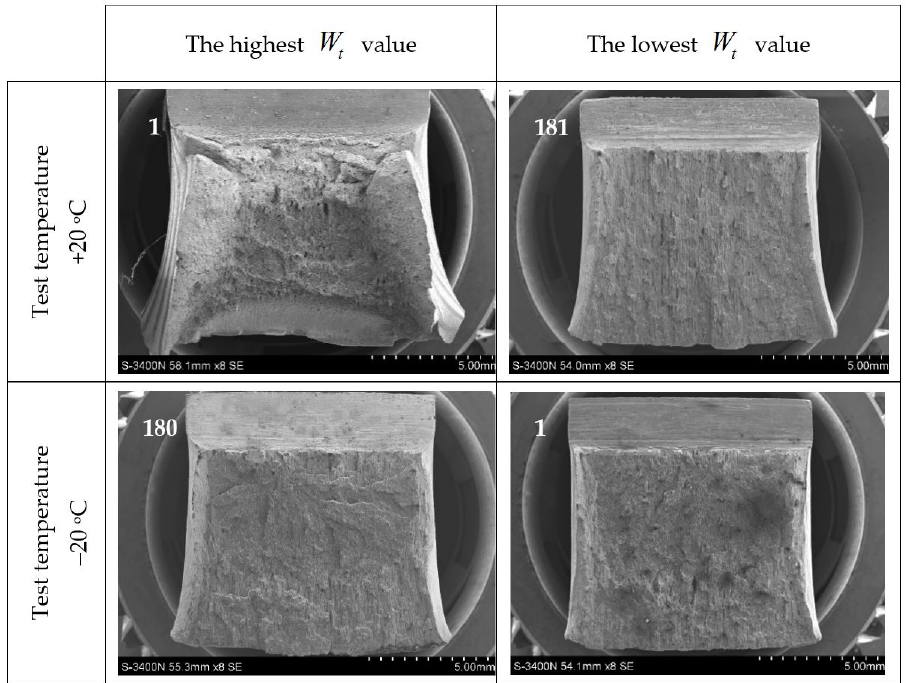
Figure 14. Characteristic impact-notch toughness test fractures obtained on samples made of S355J2+N